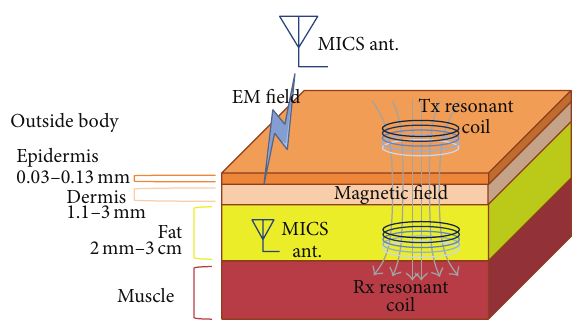
Figure 2: Inductive and electromagnetic links between the implant device and